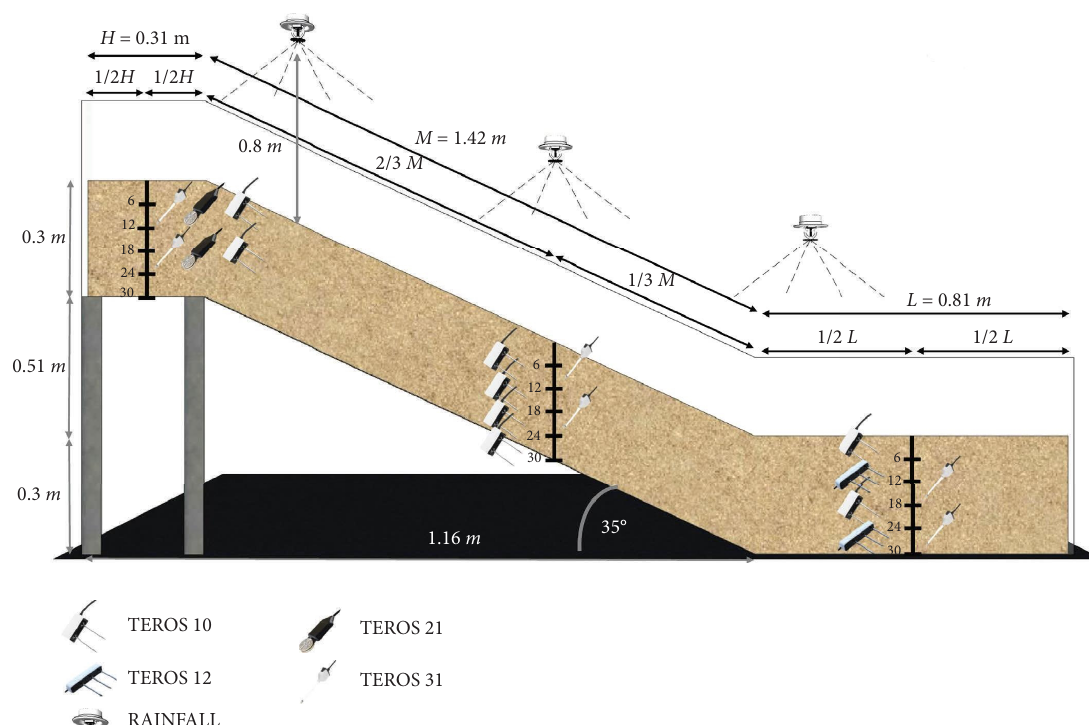
Figure 3: Positions of the embedded water-related sensors in the small-scale landslide model (modifed according to Pajalic et al. [31]).